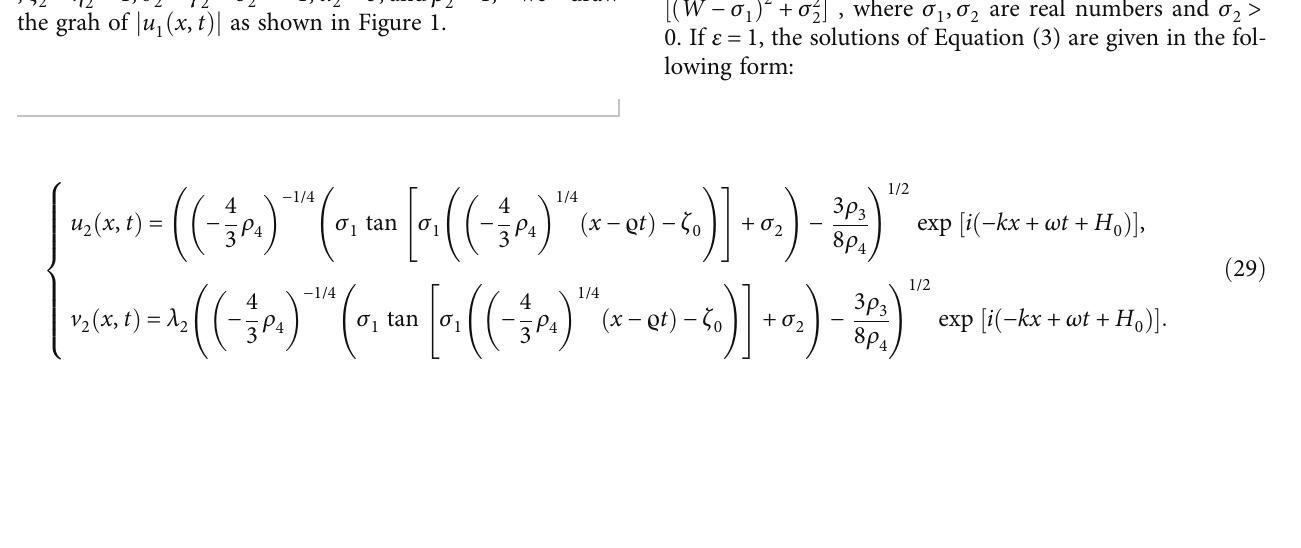
= 9, f = 5, ξ 1 1 = 1/2 2